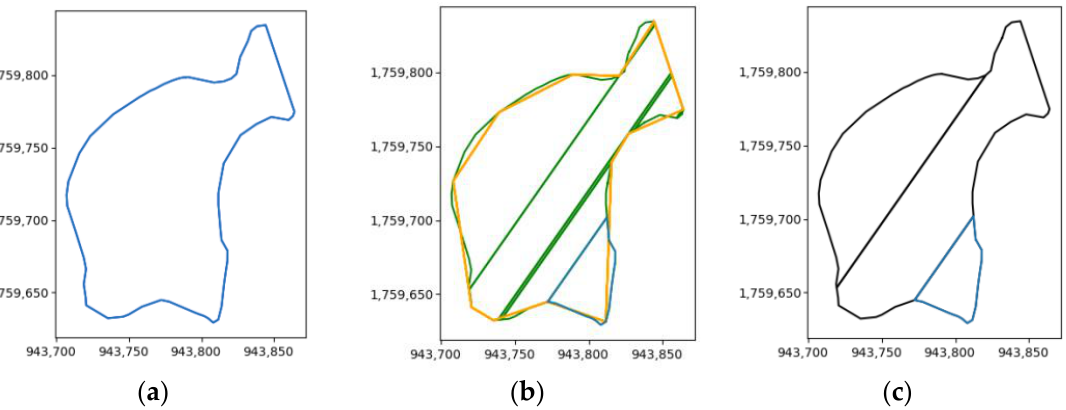
Figure 3. ( a ) Example of a target land, ( b ) the result of subfield generation, and ( c ) the result of merging subfields.